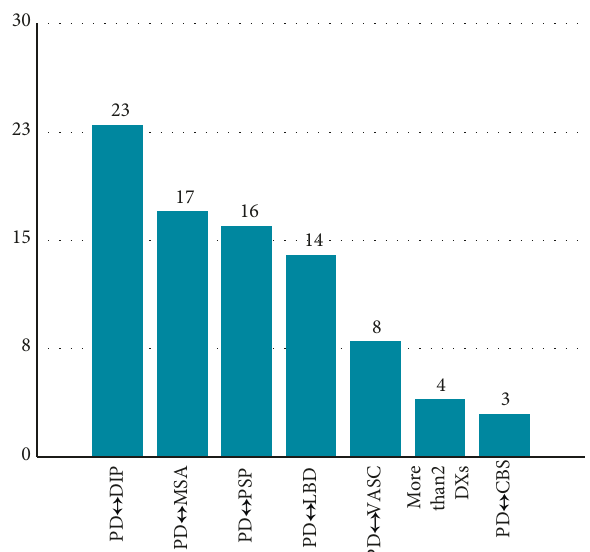
Figure 1: Changes in diagnosis in the unstable group (N � 85).